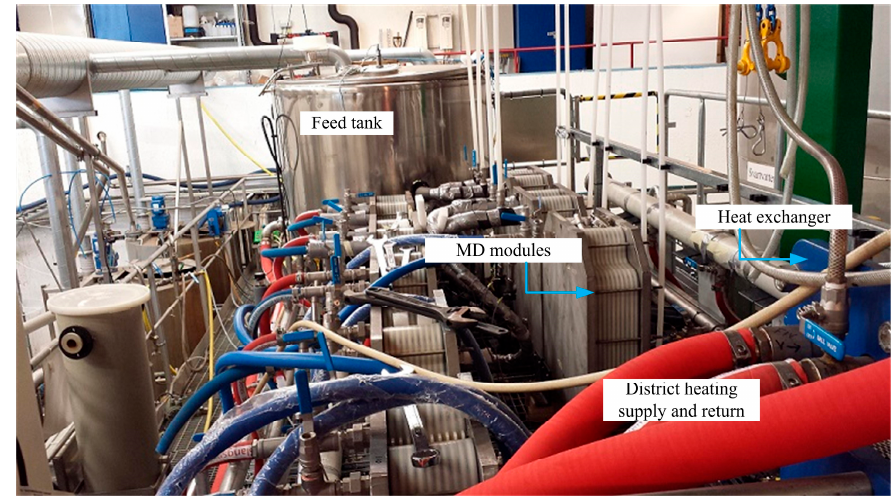
Figure 1. Xzero Pilot air gap membrane distillation system at Hammarby Sjöstadsverk testing and demonstration facility, Stockholm, Sweden.